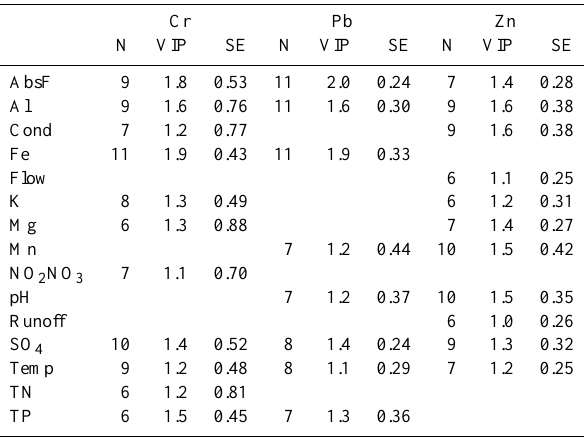
Table 4. Dominant independent variables (present in more than sites where model variable was included and, SE = VIP standard